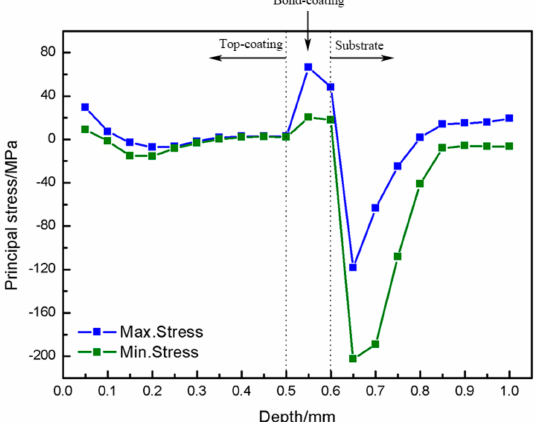
Figure 4. Residual stress distribution along the thickness direction of the as-sprayed CuAl seal